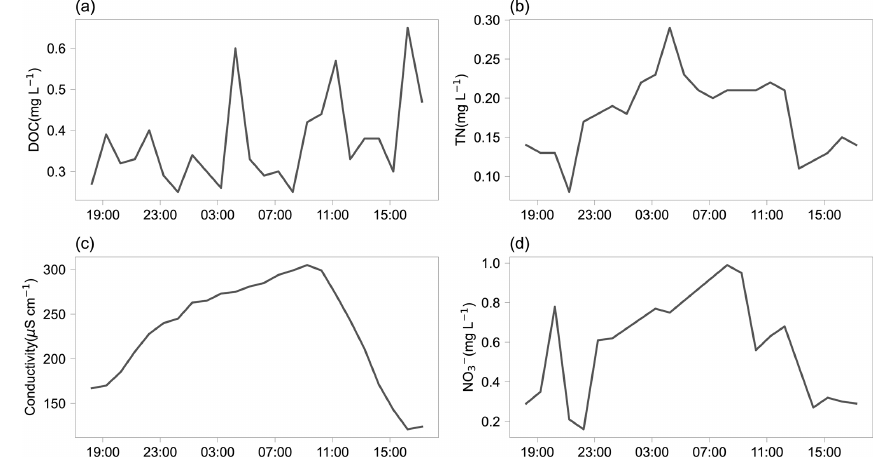
− (d) in proglacial runoff of the Qiangyong 3